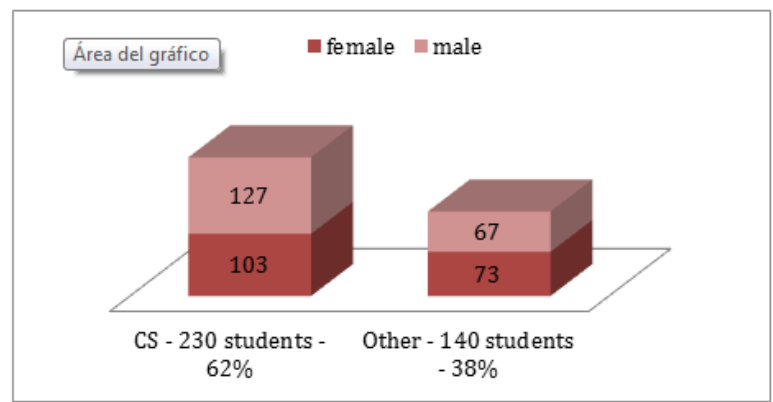
Figure 2. Distribution of the target gender (in number of participants) and domain of activity (in number of participants and